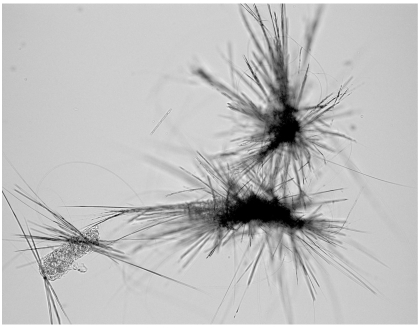
“Crystal-like” formation on schistosomula.An example of crystal-like deposit from one of the wells containing schistosomula categorized as DAMAGED from Figure 4. (Magnification ×100). Image captured using a Leitz DMRB microscope (Leica, Germany) with attached Leica DFC 420 digital camera controlled by Leica Application Suite version 3.1 software (Leica Microsystems [Switzerland] Ltd.).